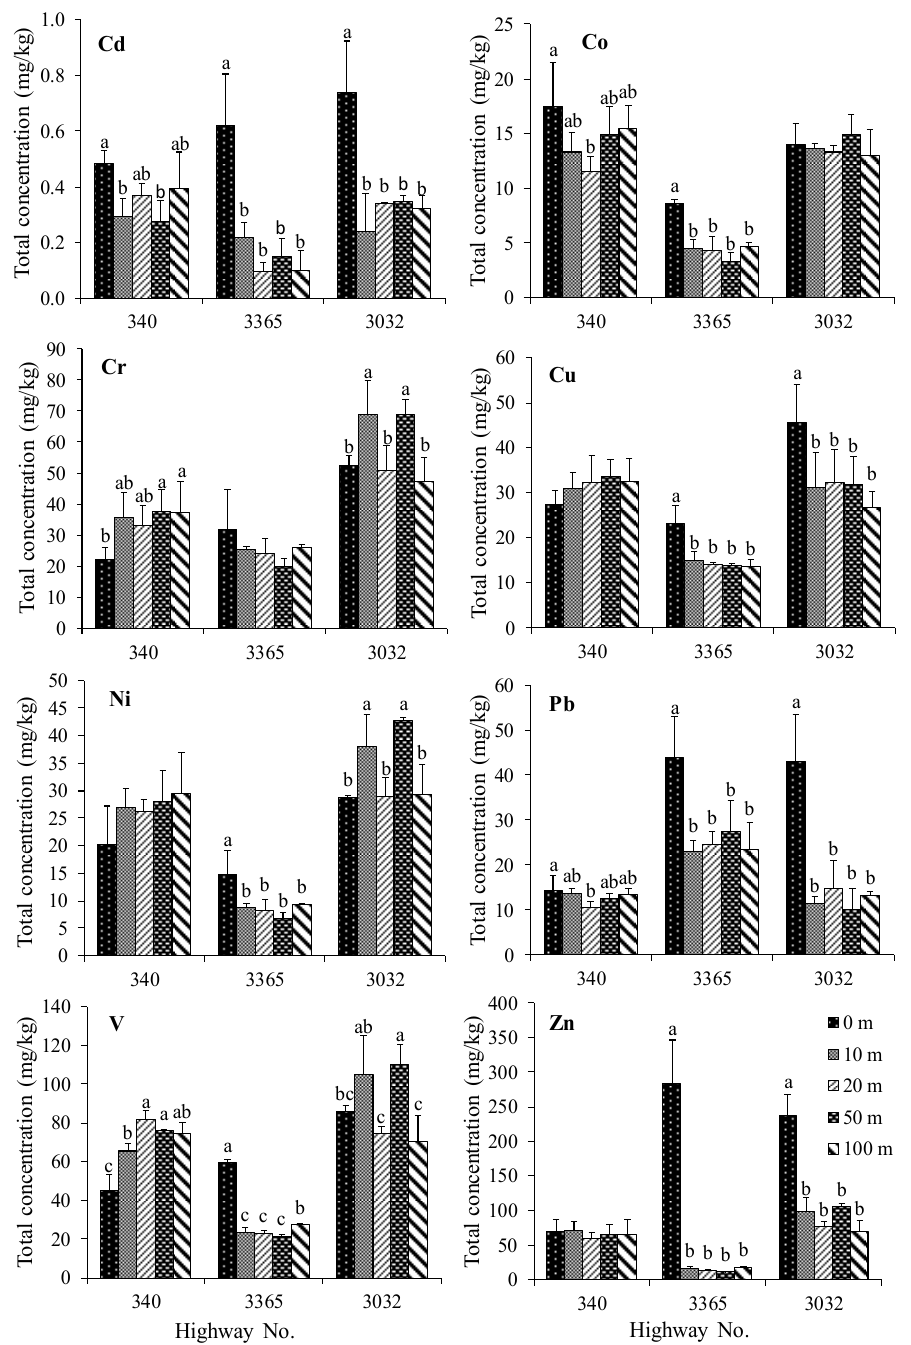
Figure 2. Mean total concentrations of Cd, Co, Cr, Cu, Ni, Pb, V, and Zn (mg kg − 1 ) in rice growing soils at the different distances from the road edge. The columns with different alphabets indicate significant differences and those without alphabets indicate insignificant differences in the soil concentrations ( p < 0.05), and error bars indicate ±SD.